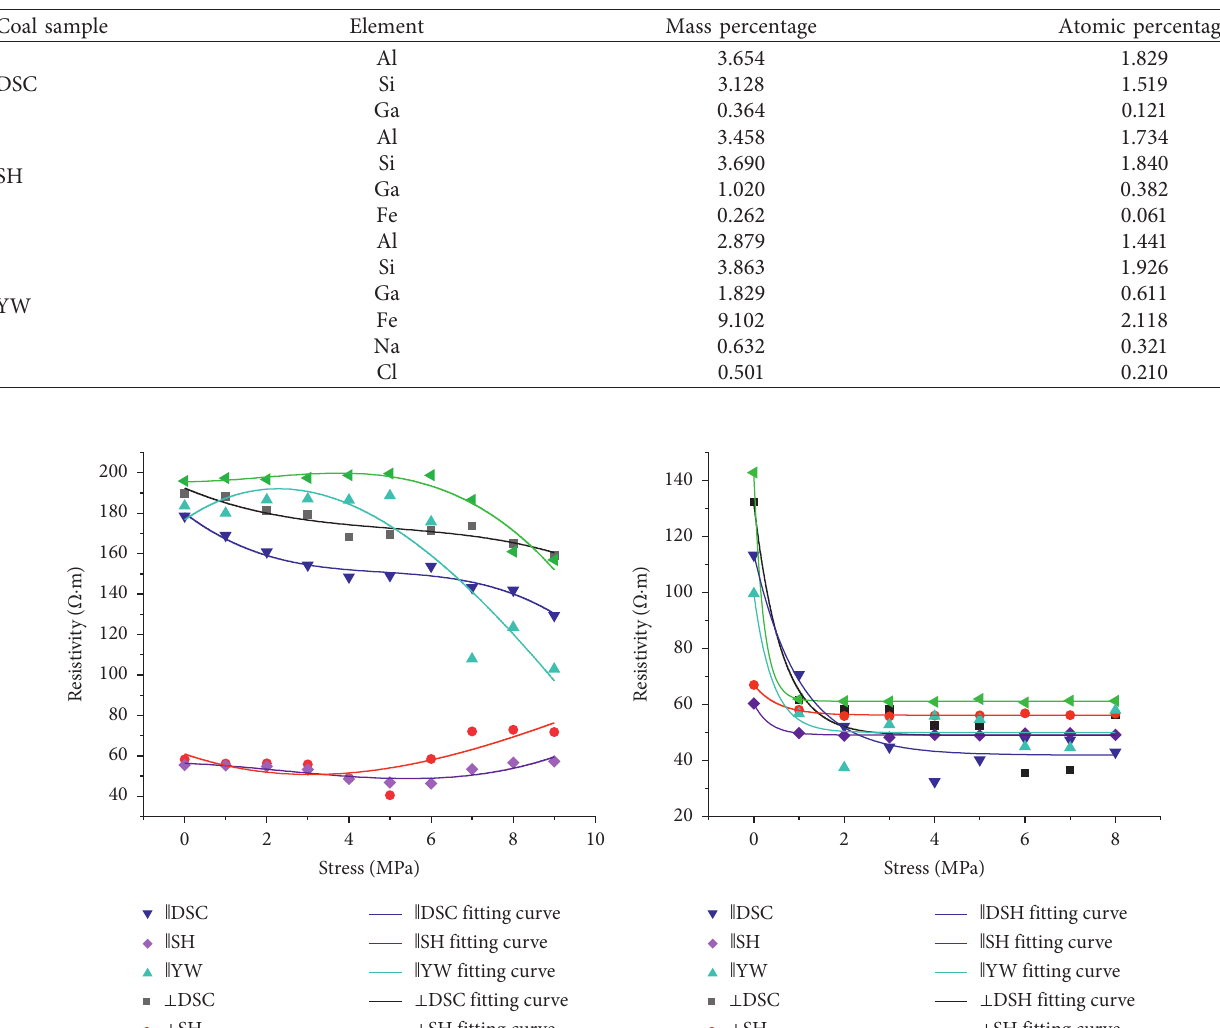
Table 3: EDS element analysis table.